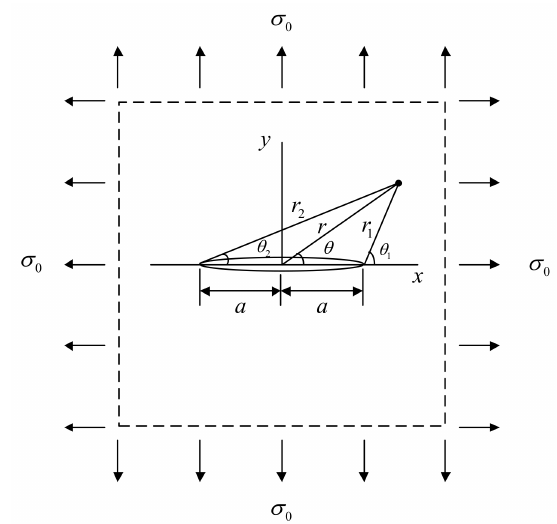
Figure A1. A crack in an infinite elastic plane subjected to biaxial